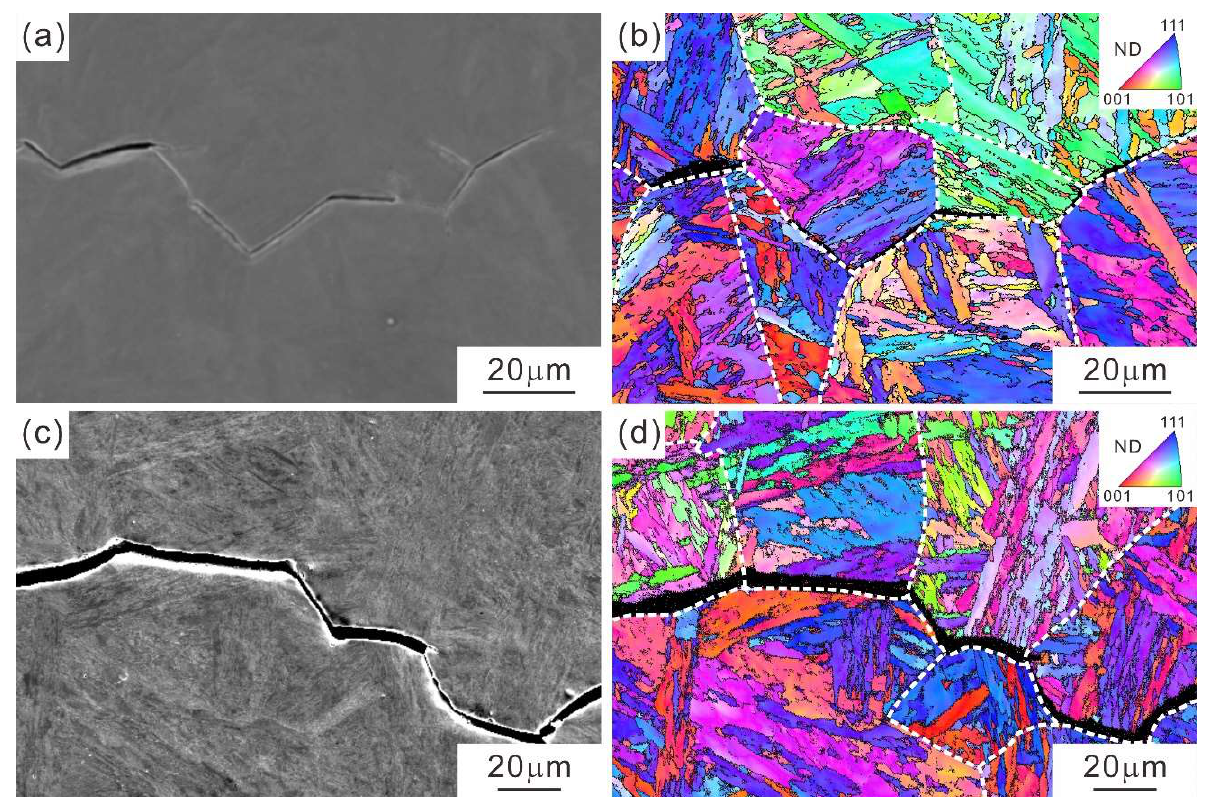
Figure 2. SEM images of the typical fracture surfaces; ( a ) intergranular surface and ( b ) quasi-cleav- age surface (center area of the image) of the hydrogen-charged specimen with H D = 0.80 wt. ppm after the slow strain rate tensile test.